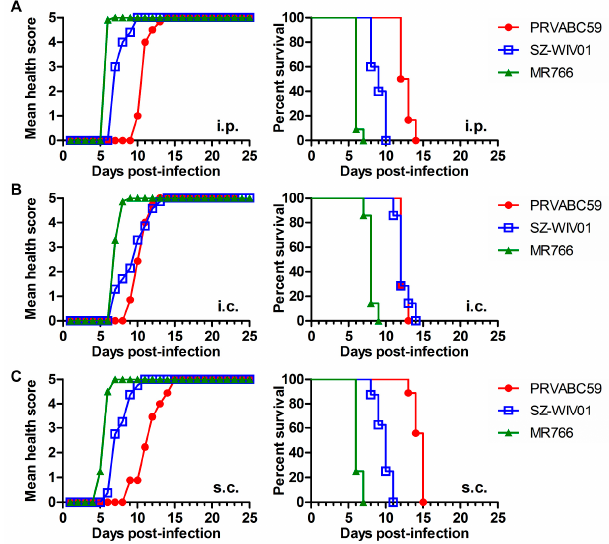
Figure 2. Pathogenic effects of the different strains of ZIKV on 1-day-old C57BL/6 mice via different infectious routes. Different ZIKV strains as indicated were used to infect the 1-day-old mouse at a dose of 10 6 TCID 50 /mouse i.p. ( A ), intracerebral (i.c.) ( B ), subcutaneously (s.c.) ( C ). Health score curve is shown on the left side while the survival rate curve was shown in right side. Each group contains 8–10 mice.